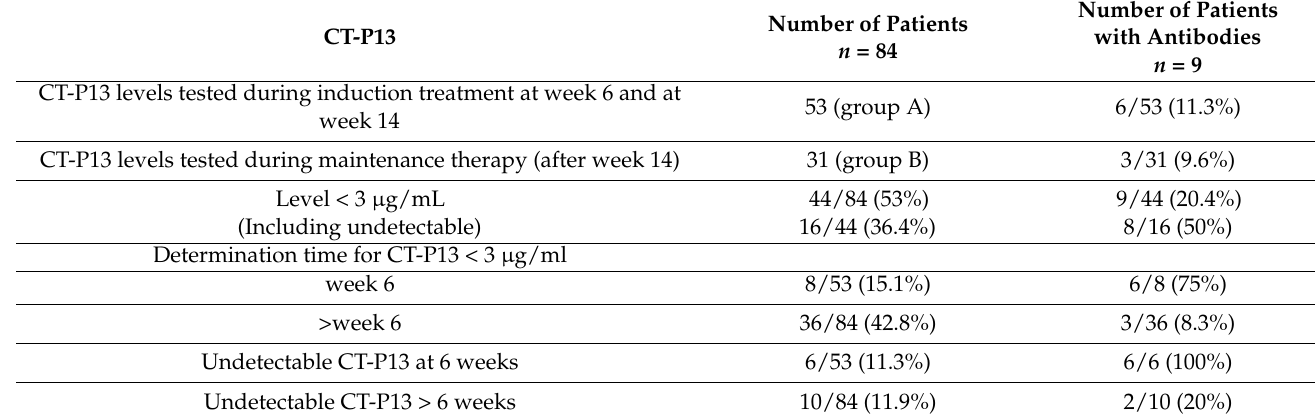
Table 2. Relationship between CT-P13 trough concentration and ADA